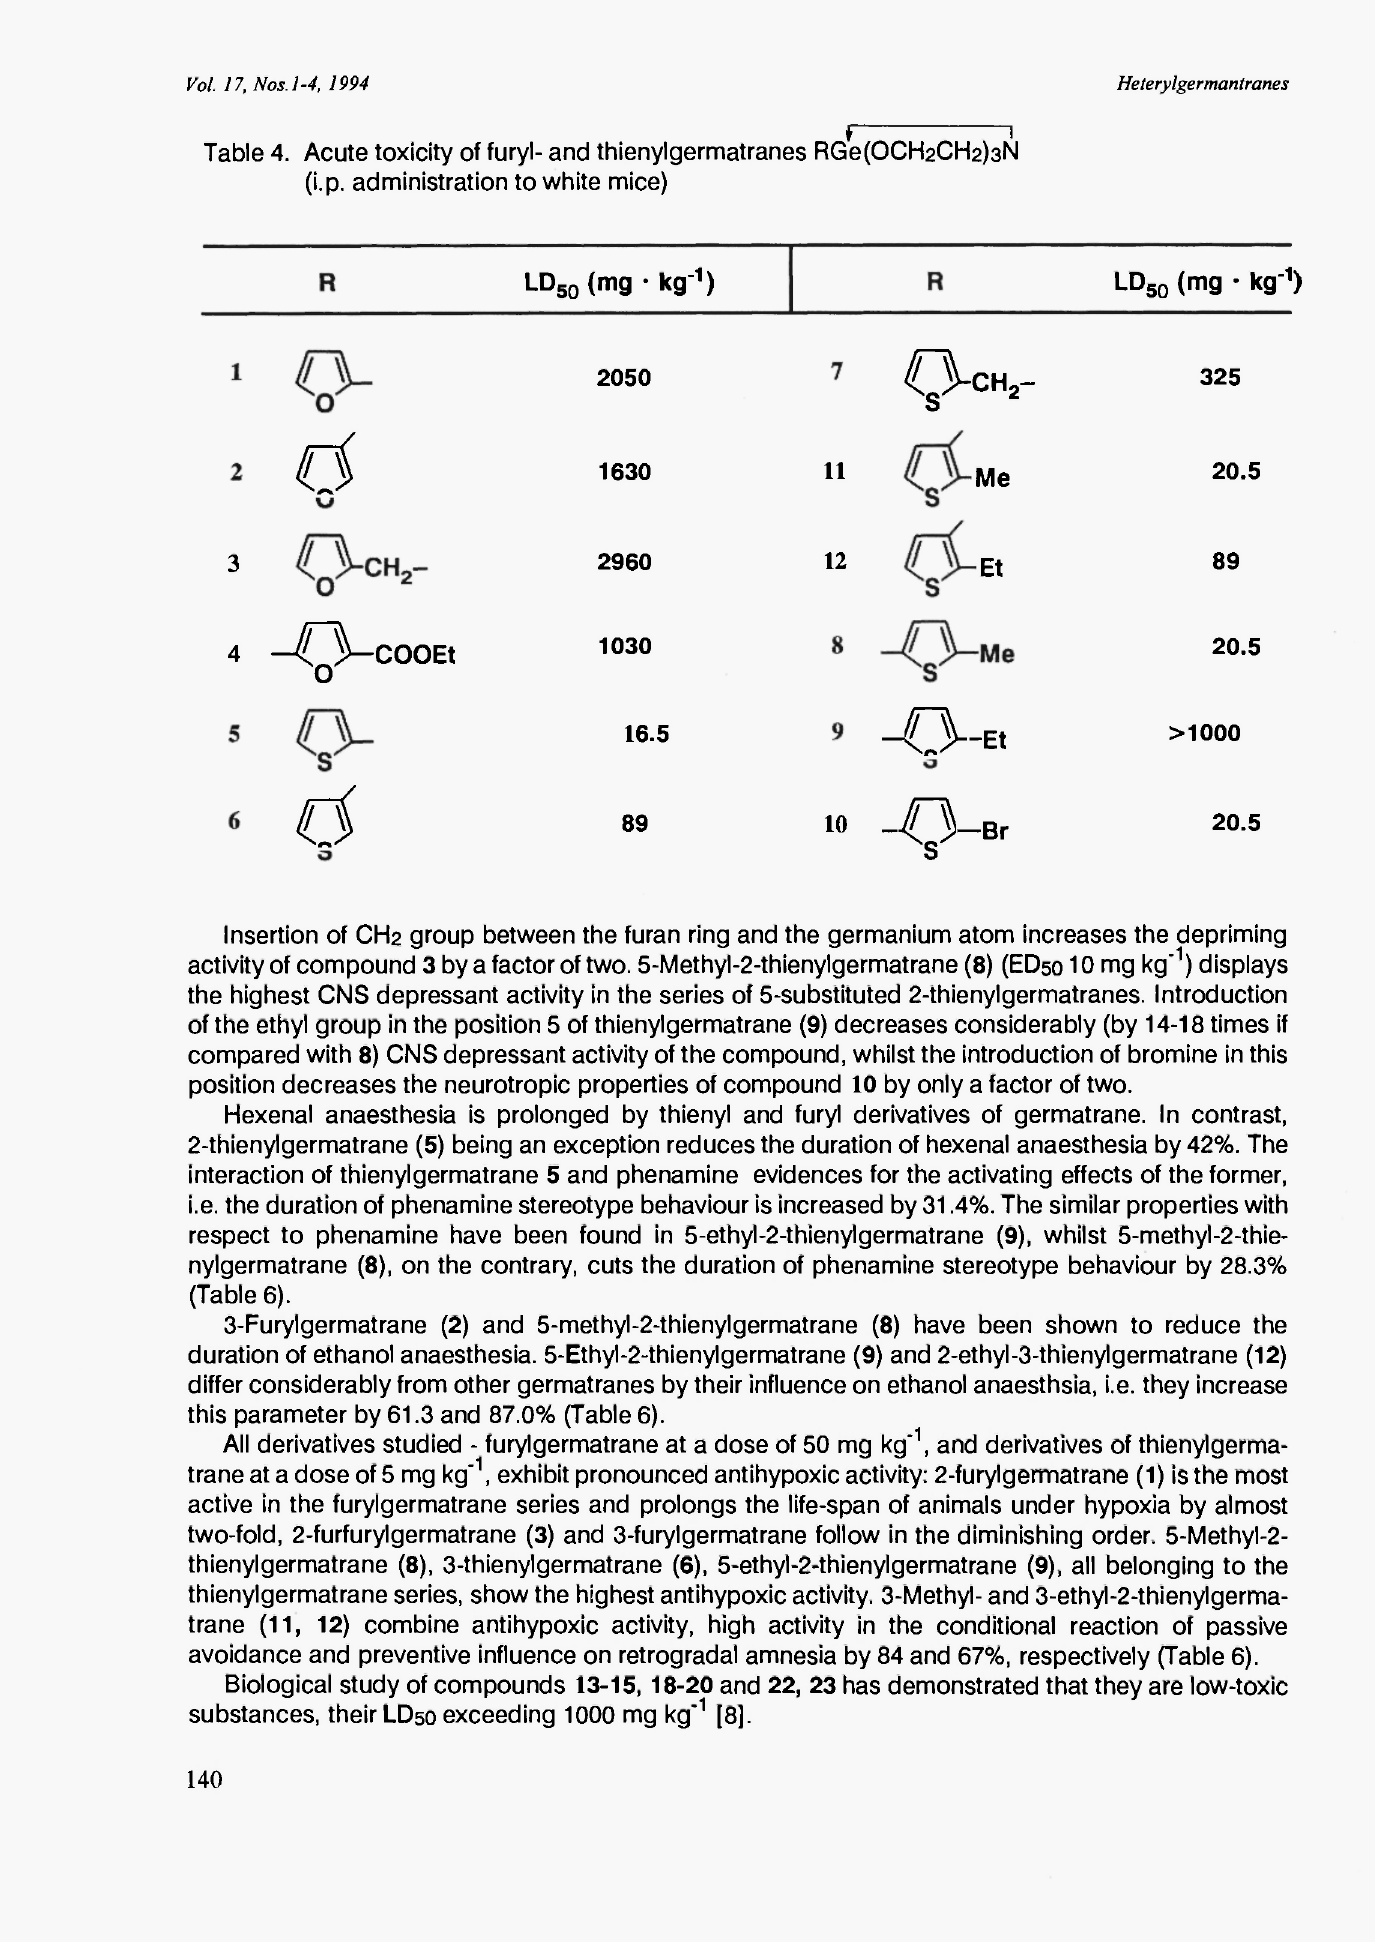
Table 4. Acute toxicity of furyl- and thienylgermatranes